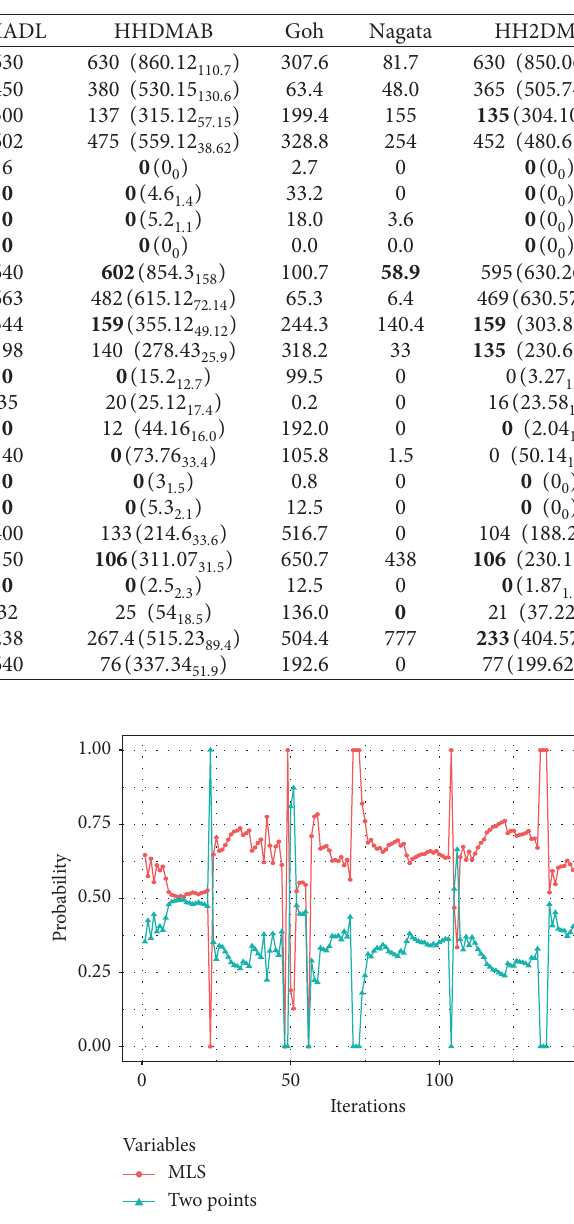
) , when available. σ